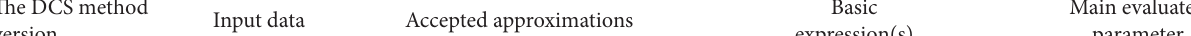
Table 1: Comparison of the main versions of the classical and computational approach of the dark current spectroscopy (DCS) method. The DCS